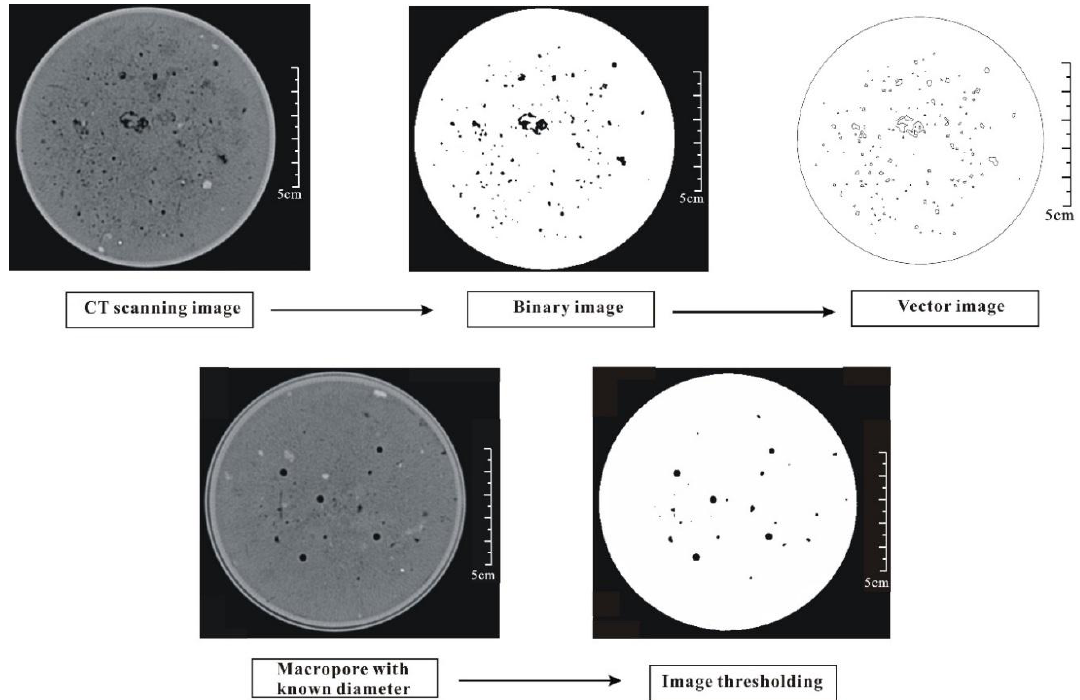
Figure 1. Procedures of image analysis in this study.